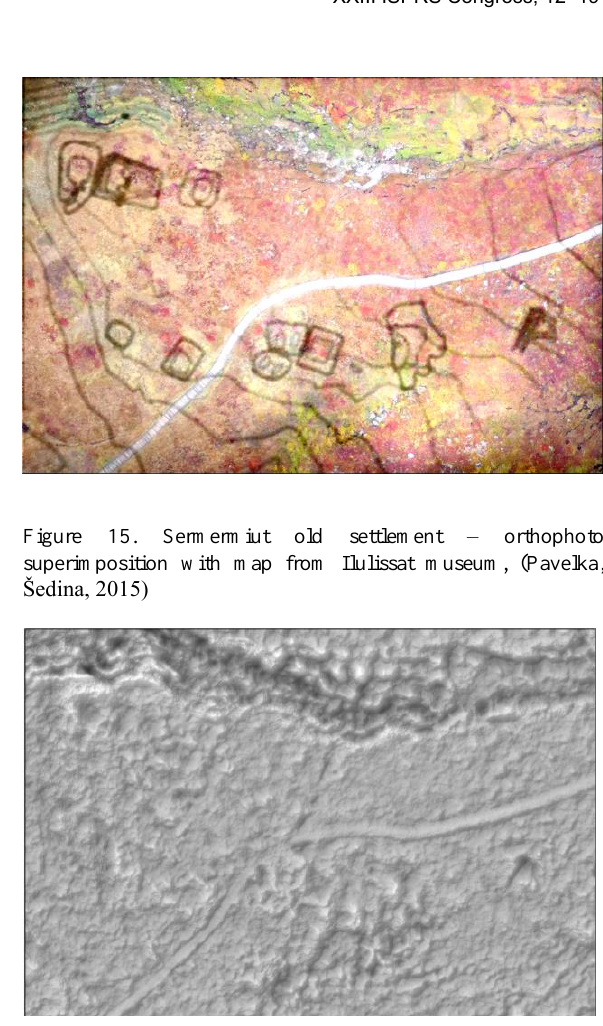
Figure 16. Sermermiut old settlement – differential digital terrain